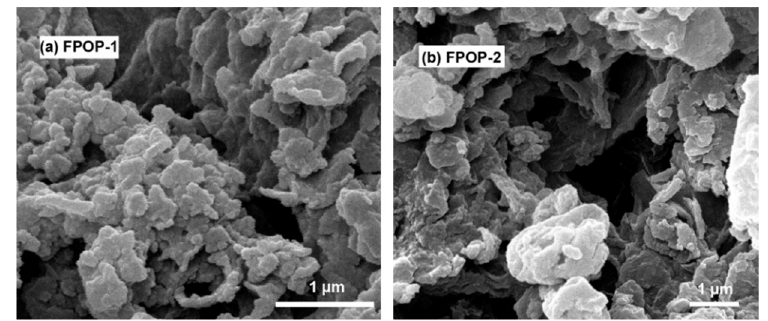
Figure 3. Solid-state 29 Si NMR spectra of FPOP-1 ( a ) and FPOP-2 ( b ).